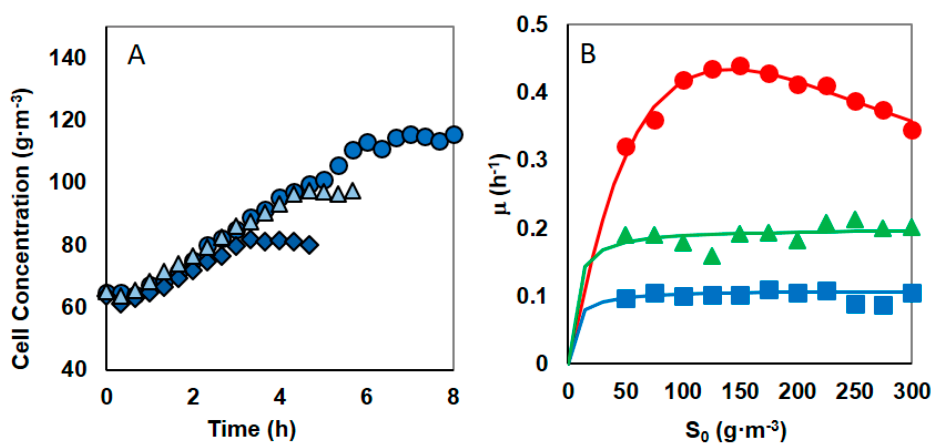
Figure 1. ( A ) The effect of the nickel presence (3.33 g · m − 3 ) on the biomass growth for different initial phenol concentrations of 100 g · m − 3 (diamonds), 200 g · m − 3 (triangles) and 300 g · m − 3 (circles). ( B ) Dependence of the growth rate on the initial phenol concentration in cultures without of nickel (red circles) and in cultures containing nickel at concentration 1.67 g · m − 3 (green triangles) or 3.33 g · m − 3 (blue squares). Table 1. Comparison of the specific growth rate of different microbial strain. Table 2. Parameters of the equations for bacterial growth on phenol in the presence of nickel. Nickel Concentration